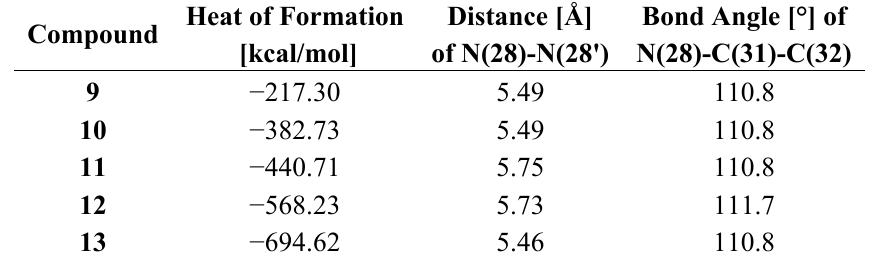
Table 2. Heat of formation (HOF) [kcal/mol], distances of N(28)-N(28') atoms [Å] and